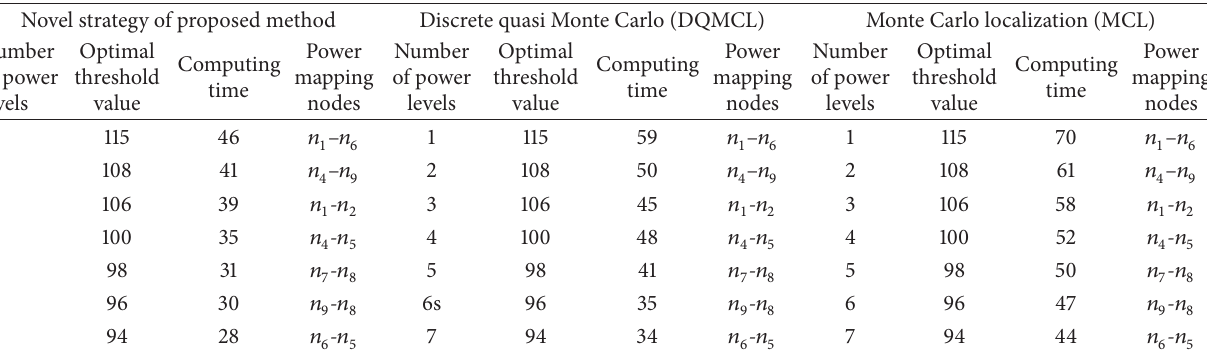
Table 1: Analysis of computational time with standard threshold